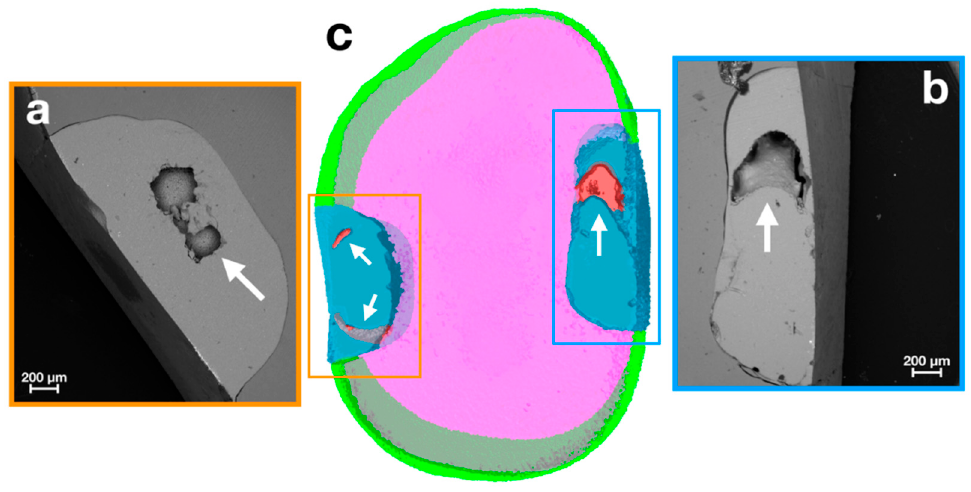
Figure 5. SEM observations of restorations gaps ( a , b ) and µ -CT coloured 3D reconstruction of a BT representative sample ( c ). SEM observations of the restorations presenting several defects (arrows in ( a , b )) and µ -CT coloured 3D reconstruction of a BT representative sample with defects (arrows in ( c )). The void formation in micrograph ( a ) is split in two different defects in the 3D model (orange inset of ( c )). The void formation in micrograph ( b ) represents the defect inside the restoration (blue inset of ( c )). Green—enamel; pink—dentin (in transparency the superposition of the dentin with the enamel); blue—restorations (in transparency superposition of the dentin with the restoration); red—defects.